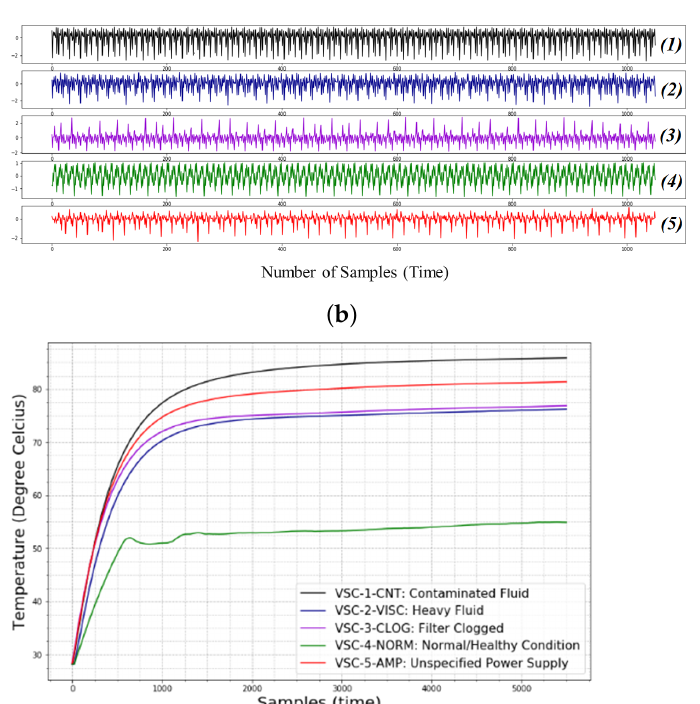
Figure 4. ( a ) Raw vibrational signals and ( b ) continuous temperature monitoring results for (1) VSC-1-CNT: Contaminated Fluid, (2) VSC-2-VISC: Heavy Fluid, (3) VSC-3-CLOG: Filter Clogging, (4) VSC-4-NORM: Normal/Healthy Condition and (5) VSC-5-AMP: Unspecified Power